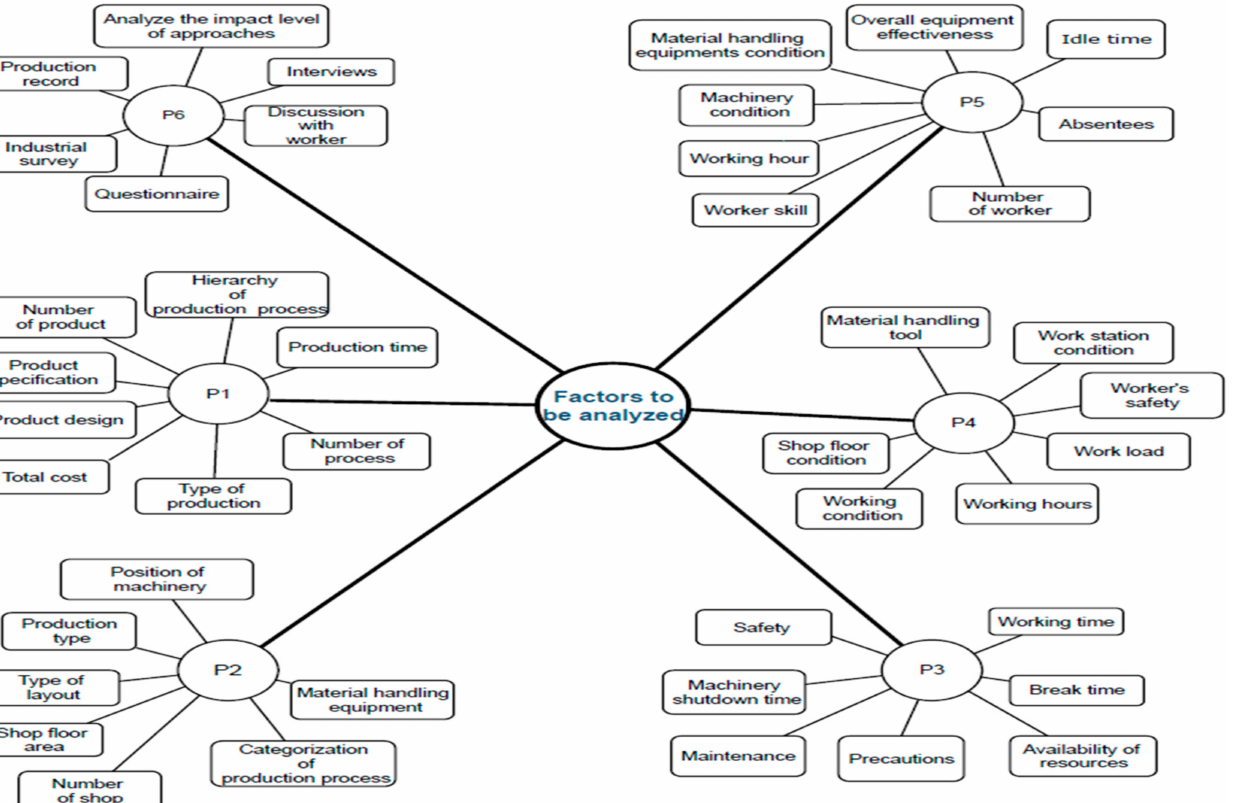
Figure 11. Analyze factor for the elimination of